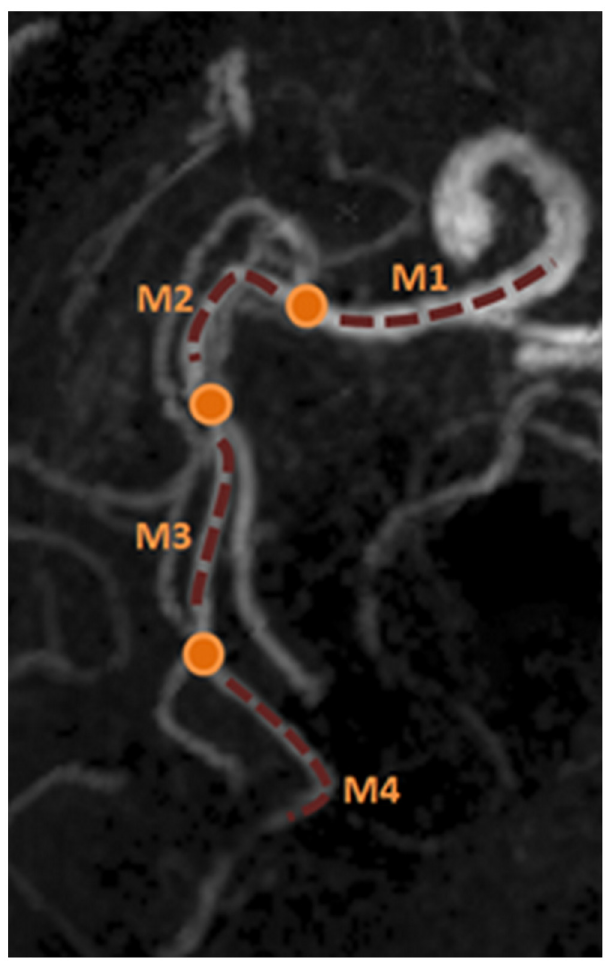
Fig 1. Definition of MCA segments for SVB comparison. The orange dots identify the bifurcations and the dotted lines delineate the different segments (M1-M4) of the MCA artery. Note that the oblique projection direction is used to better visualize the different